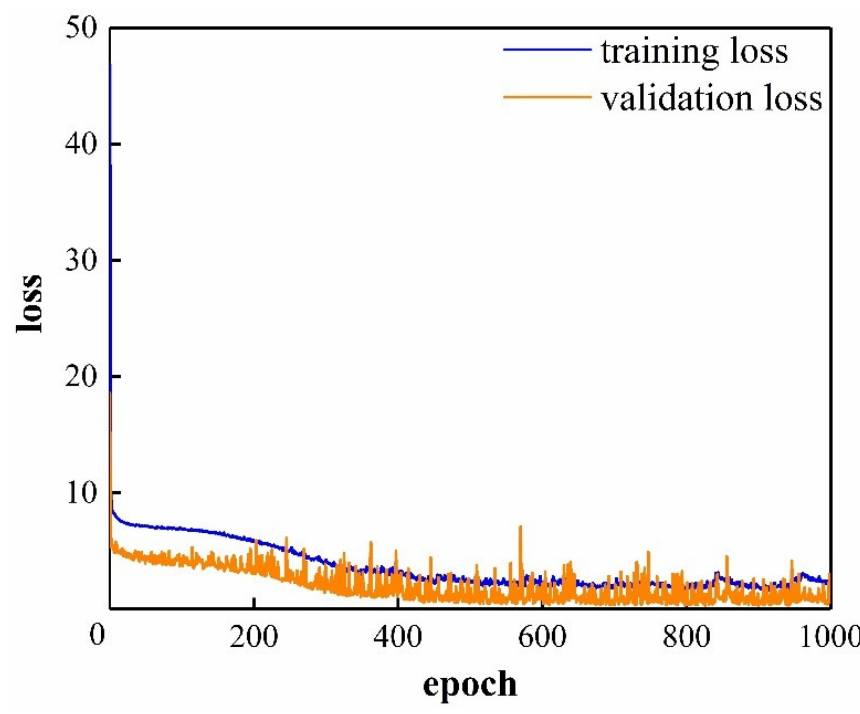
Figure 5. Loss curve of model 1.